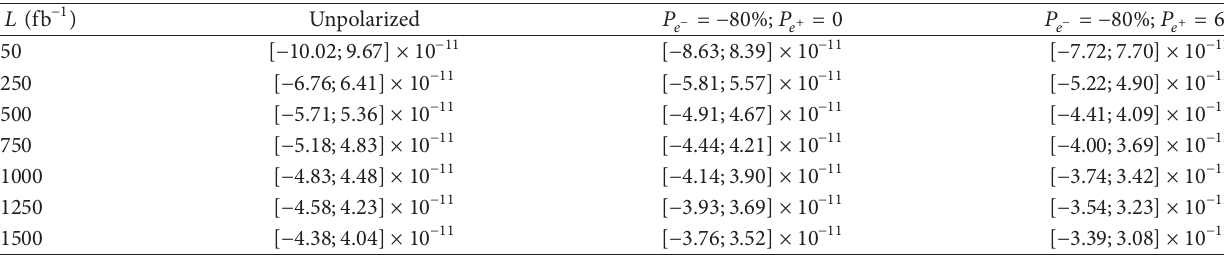
Table 3: Sensitivity of 𝑓 𝑆0 /Λ 4 at 95% CL for √𝑠 = 1.4 TeV in units of GeV −4 .